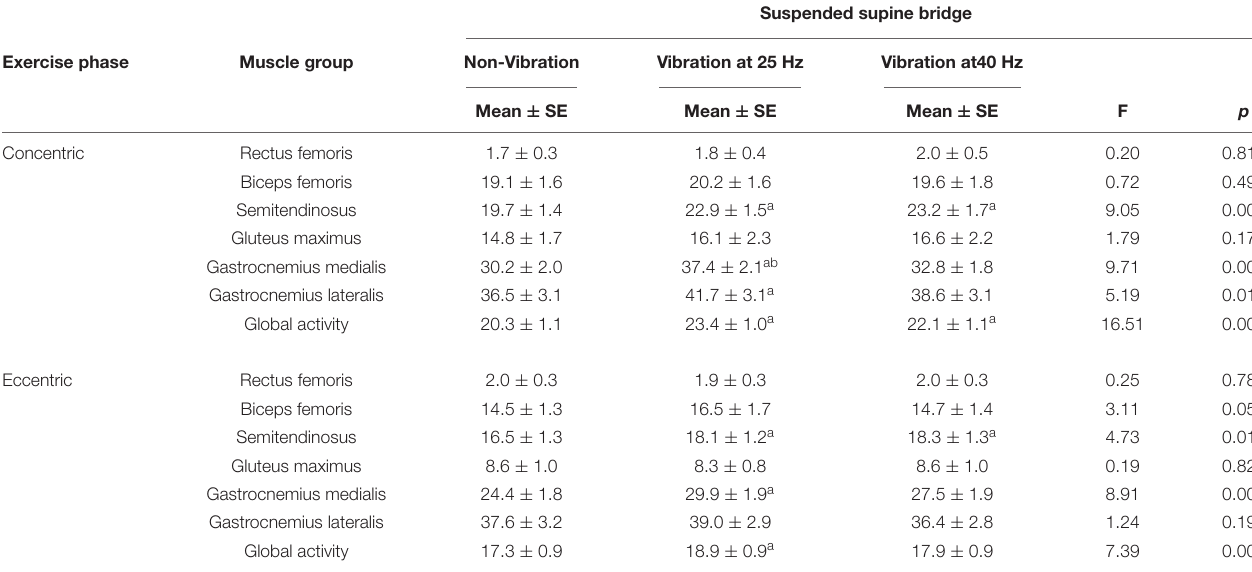
TABLE 1 | The sEMG activity for each analyzed muscle under suspended supine bridge